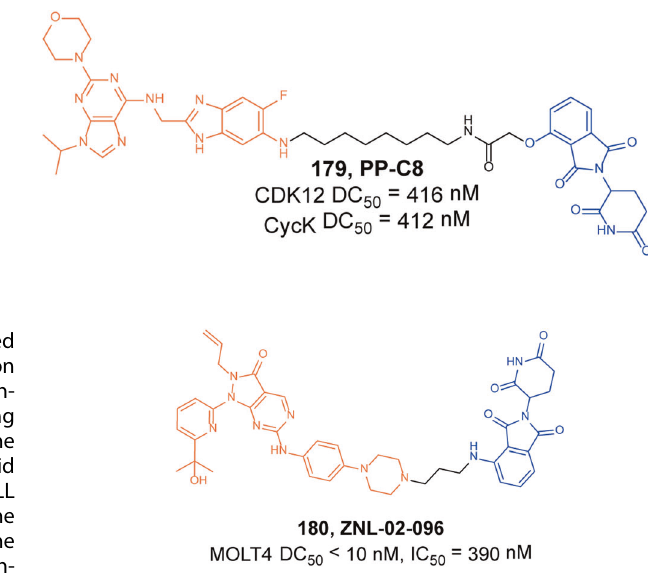
Fig. 48 The representative PROTAC targeting